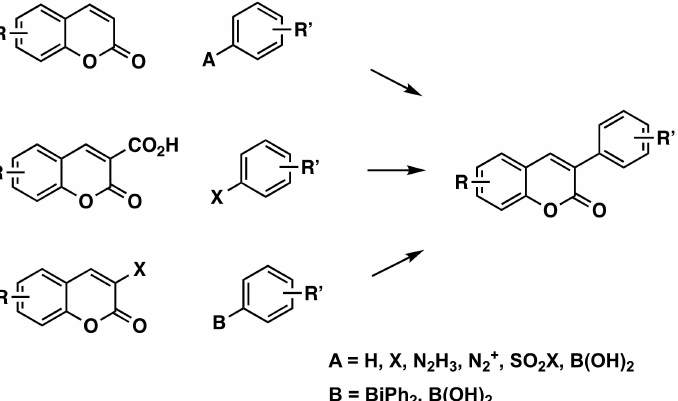
Figure 3. One of the synthetic routes to obtain 3-phenylcoumarins: coumarin coupling with the benzene